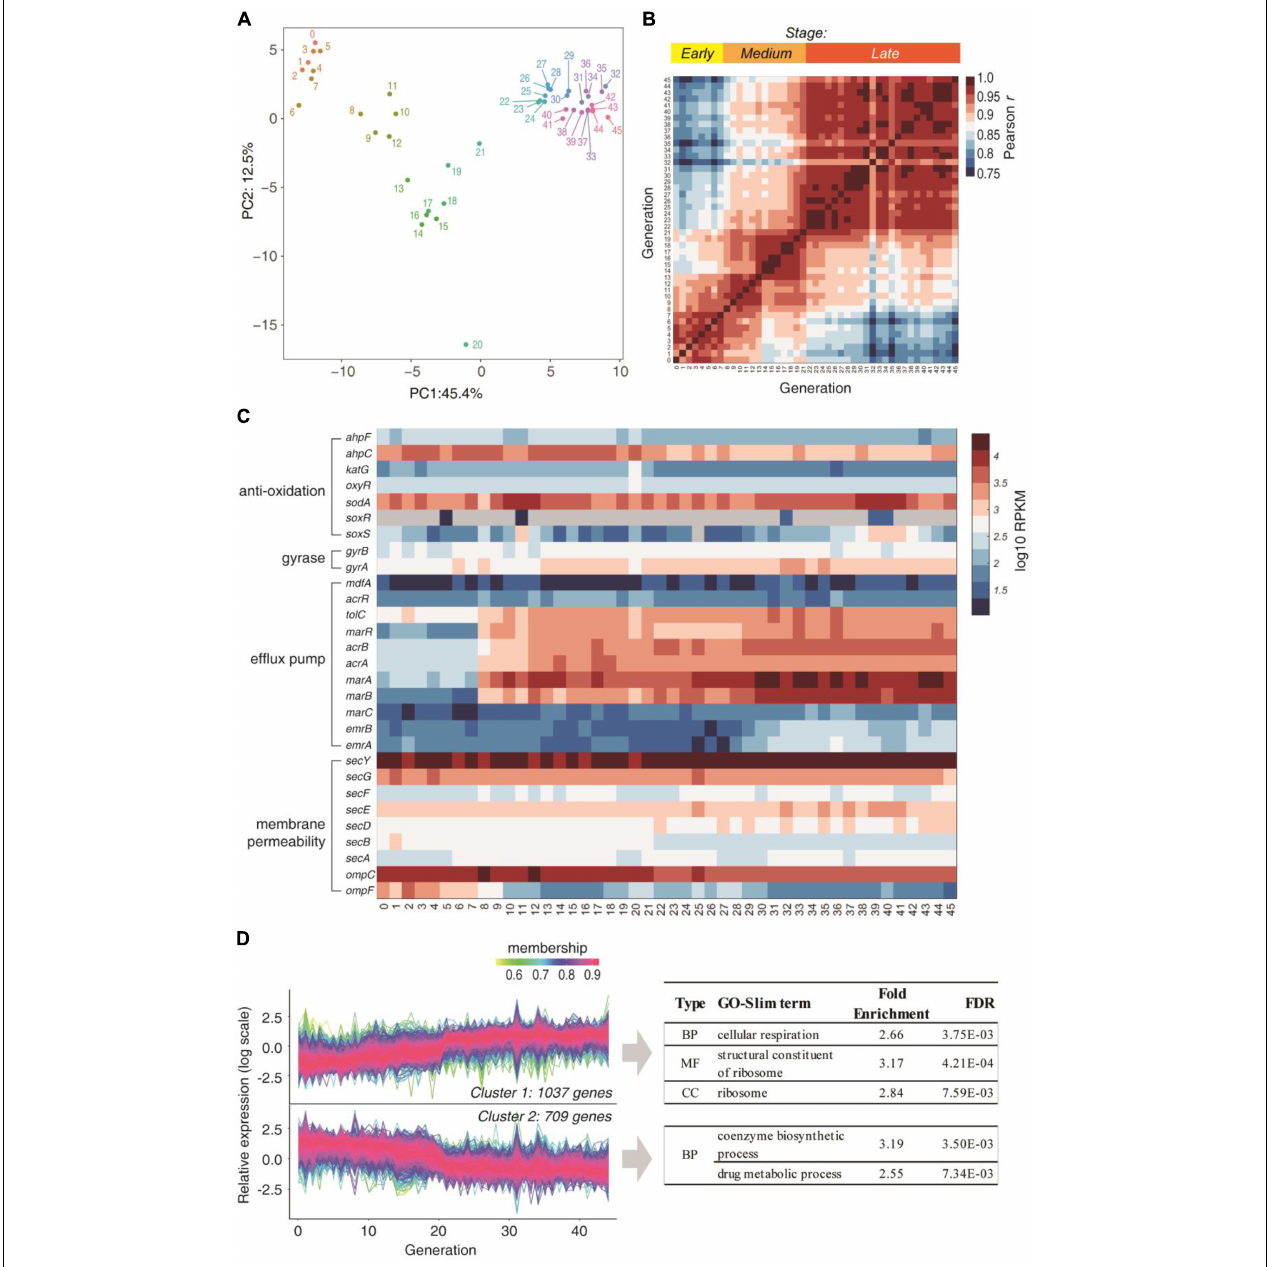
FIGURE 2 | Transcriptome changes during the subculture. (A) PCA analysis of the gene expression profiles of each generation. Numbers denote the generation. (B) Mutual Pearson correlation coefficients of log RPKM values between each two generations. (C) Temporal change of gene expression of genes that are involved in traditional AR mechanisms. (D) Expressed genes were clustered into two clusters according to the expression trend over the generations. The GO-Slim terms with fold enrichment > 2 and FDR < 0.01 were filtered and